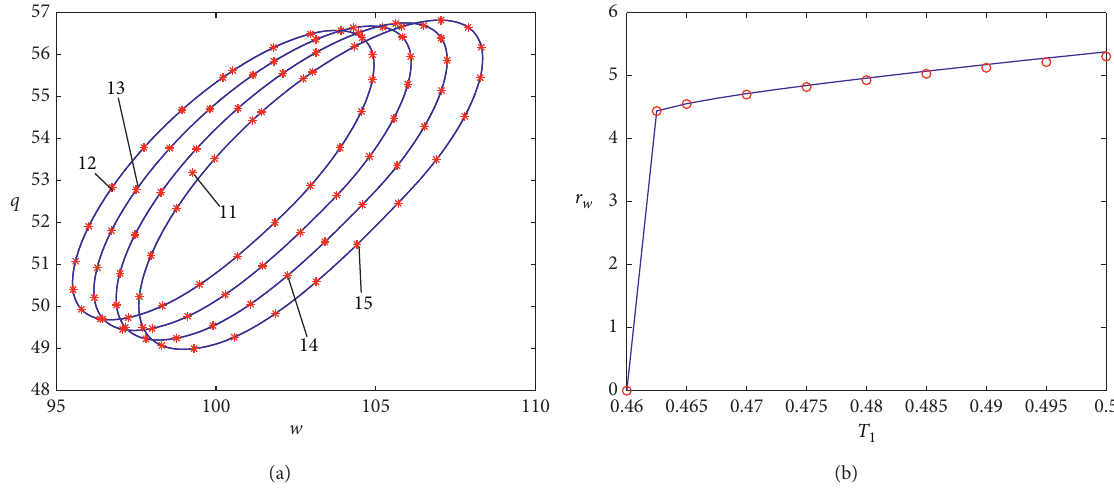
, l ,l , l , and l � 0 . 46 ,T � 0 . 47 ,T � 0 . 48 , T � correspond to T 1 2 3 4 5 1 1 1 1